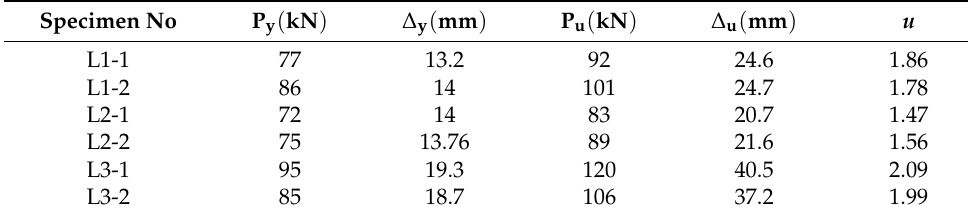
Table 5. Main mechanical properties of